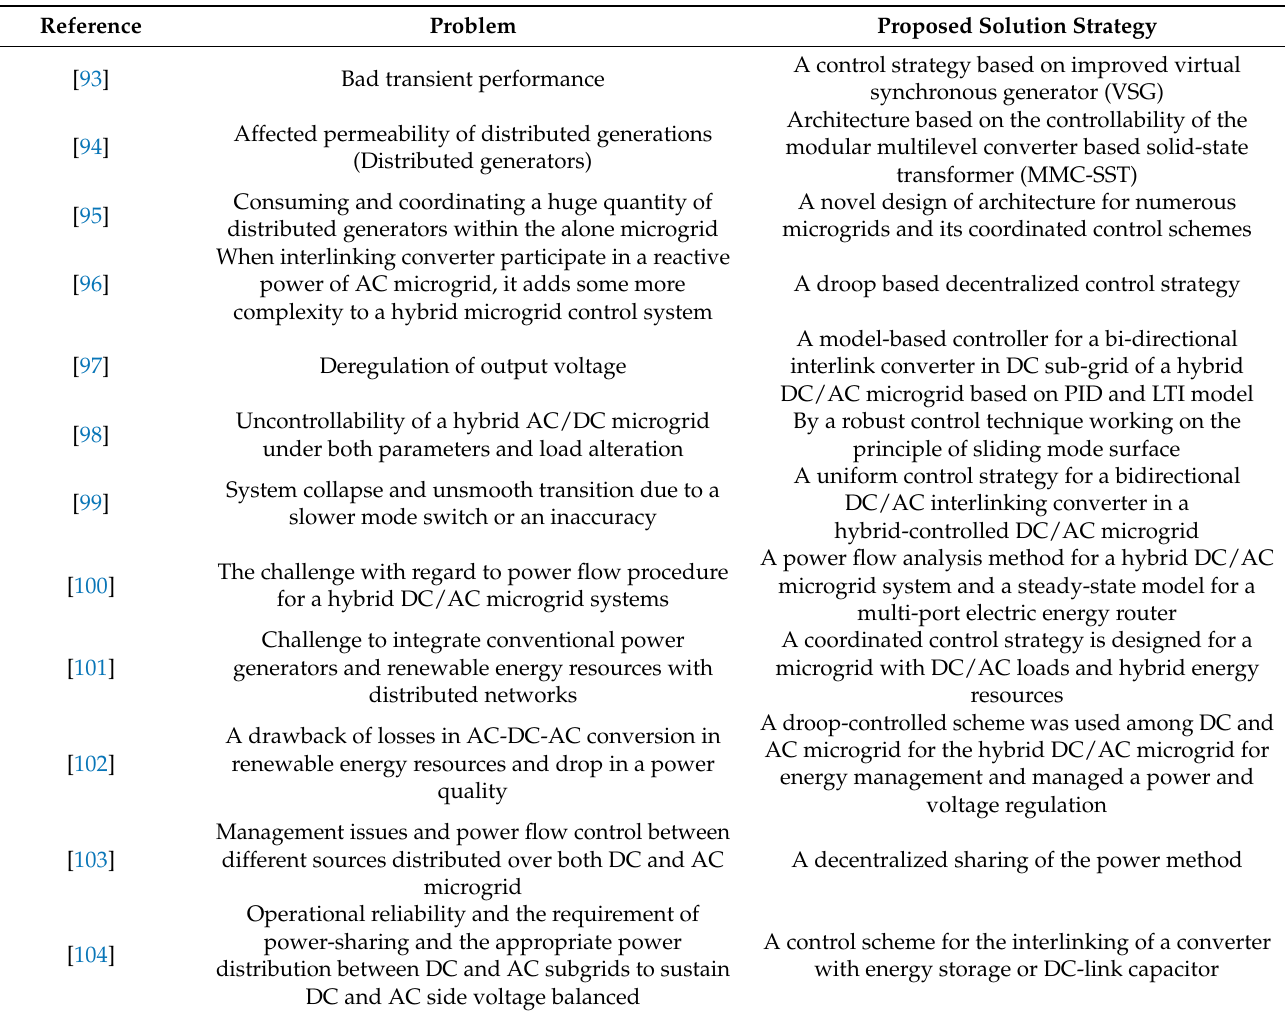
Table 4. Problems and their solution in power generation and sharing